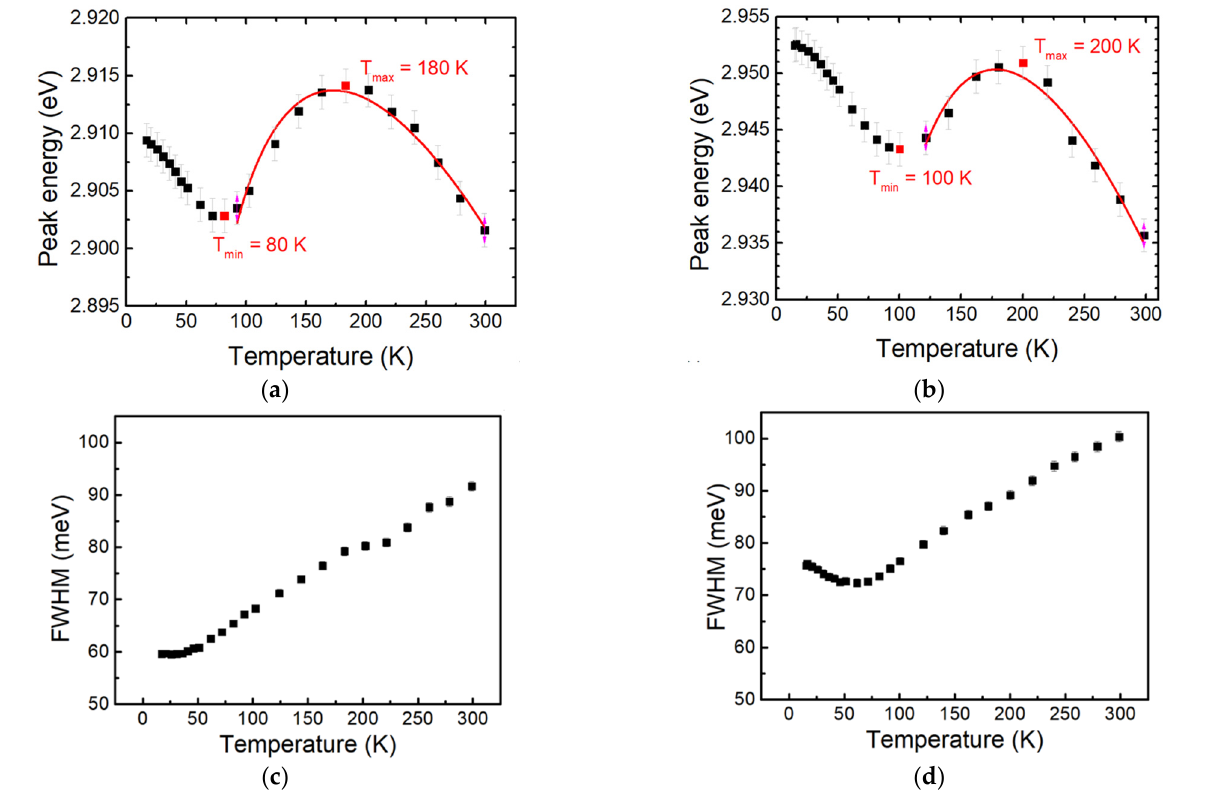
Figure 3. Temperature dependence of ( a ) peak energies of Sample 1, ( b ) peak energies of Sample 2, ( c ) FWHM of Sample 1, and ( d ) FWHM of Sample 2. Error bar is calculated standard